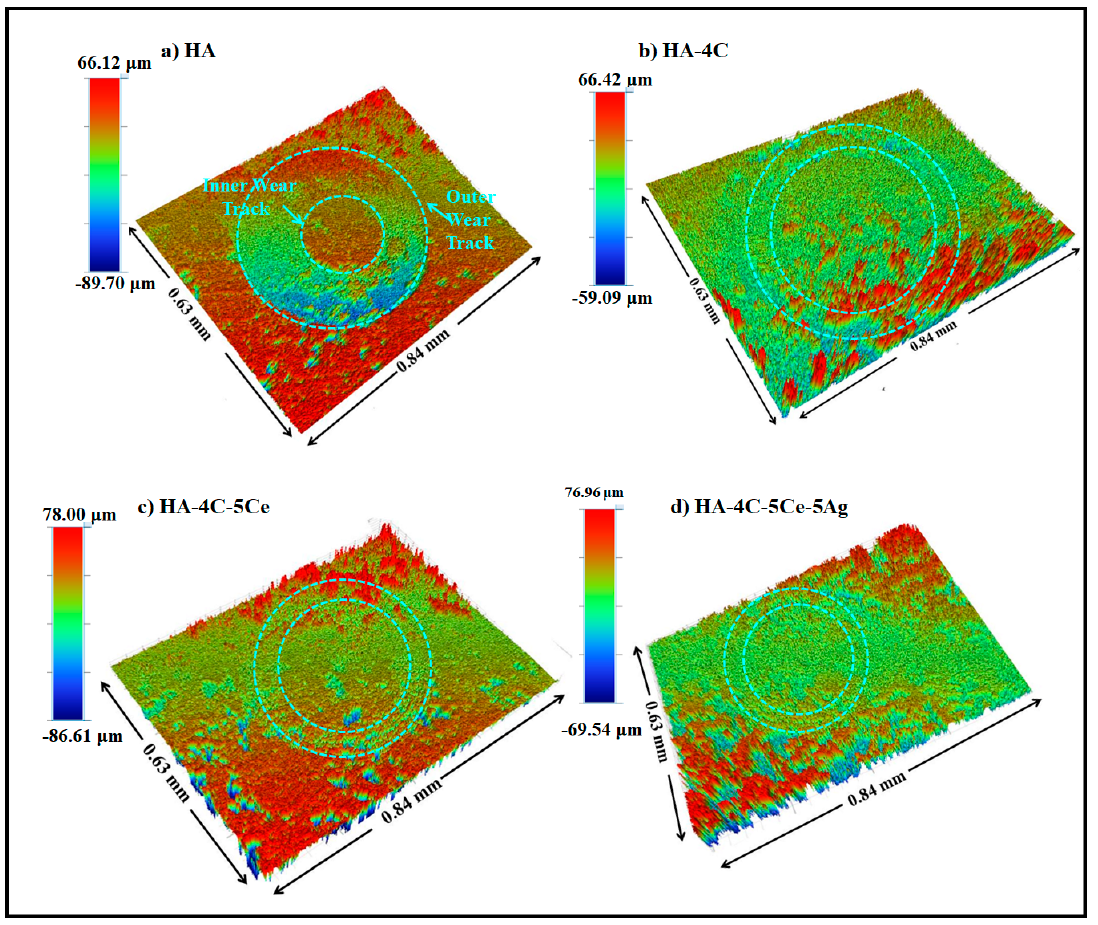
Figure 7. Three-dimensional images ( a – d ) observed by surface profilometery of the worn surface scar of HA, HA-4C, HA-4C-5Ce, and HA-4C-5Ce-5Ag.